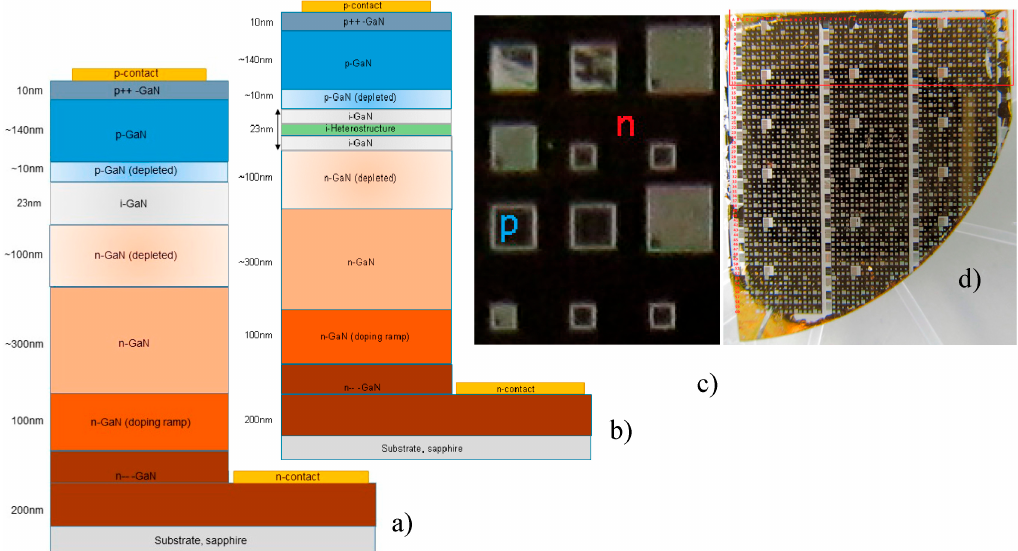
Figure 1. Schematic side-view representation of PIN-diodes based on ( a ) the GaN reference and ( b ) the InGaN/GaN and InAlN/GaN DHS; ( c ) distant and ( d ) close top-view photo of the PIN-diodes.